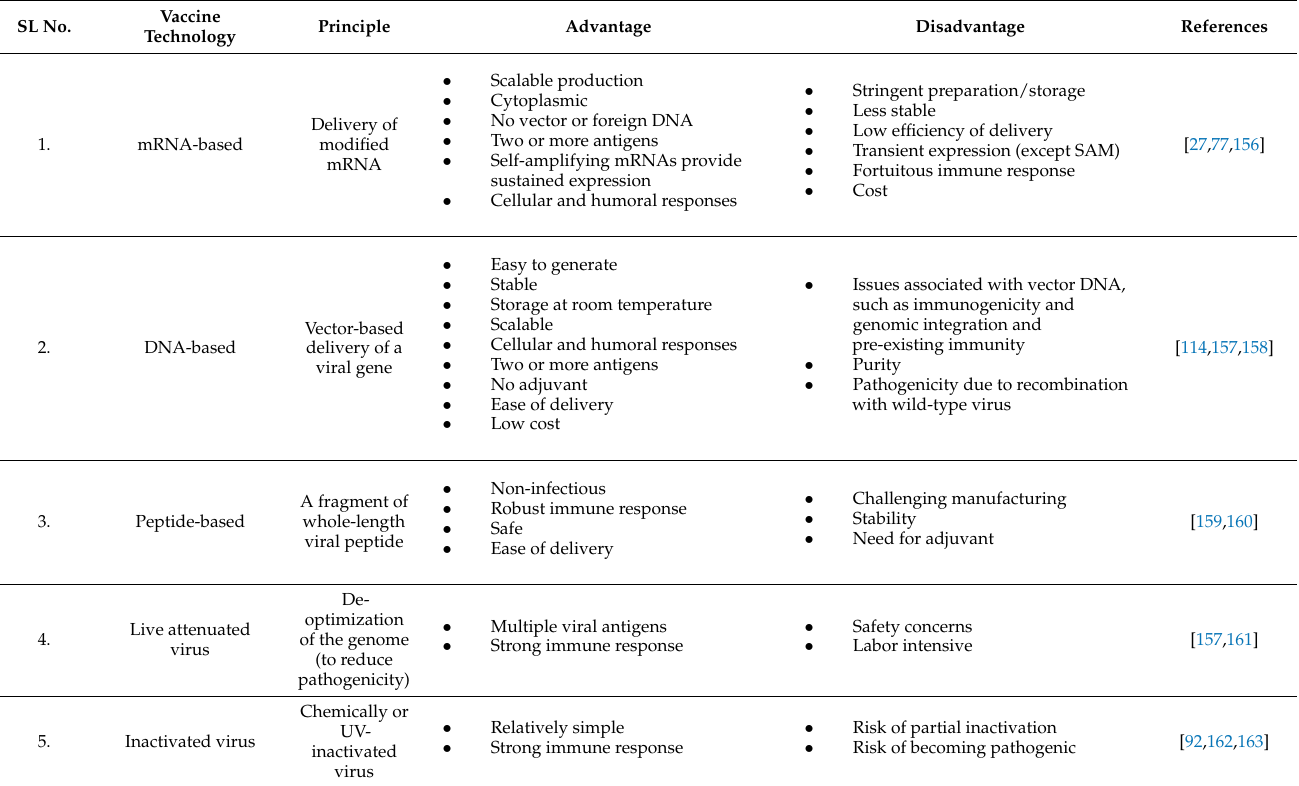
Figure 2. Various (numbered) stages involved in COVID-19 pathogenesis that might be used as targets for targeted treatment and vaccine development (reproduced from [155]). Table 3. Vaccine platforms against SARS-CoV-2.